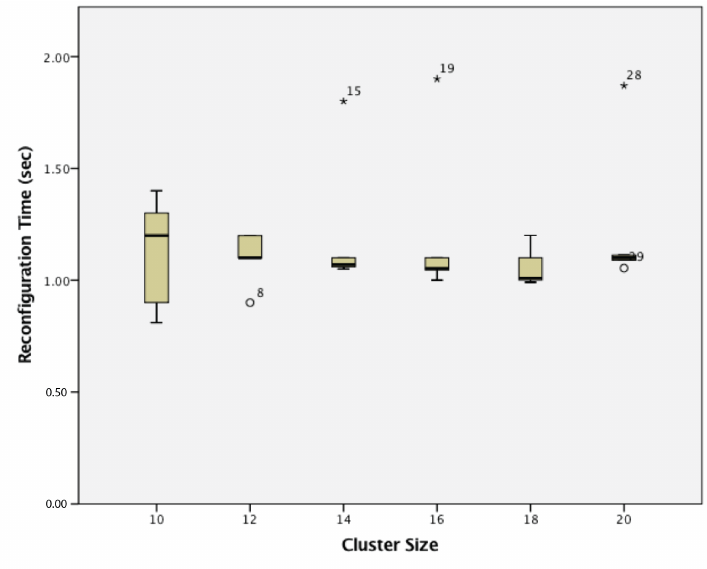
Figure 24. Reconfiguration time of dynamic wireless sensor nodes.